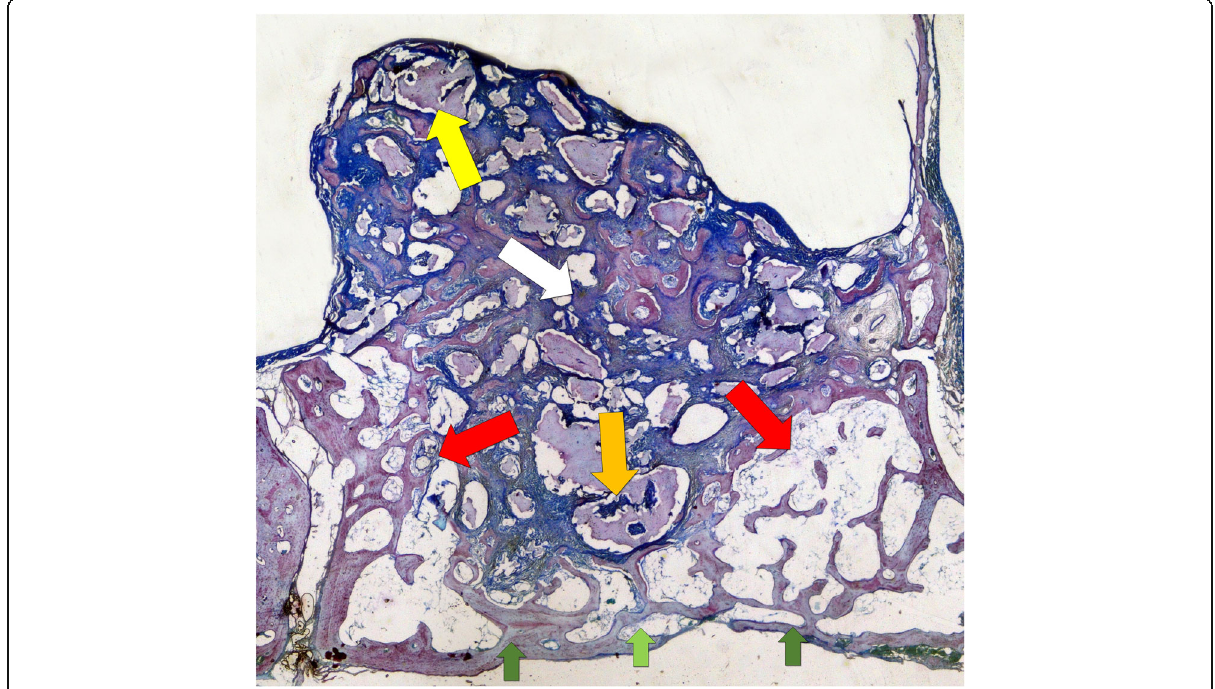
Fig. 2 The various regions evaluated at the histomorphometric analyses. Bone walls (red arrow); middle (white arrow); sub-mucosa (yellow arrow); close-to-window (orange arrow). The antrostomy region was also evaluated at the medial and lateral edges (dark green arrows) and in the middle aspect (light green